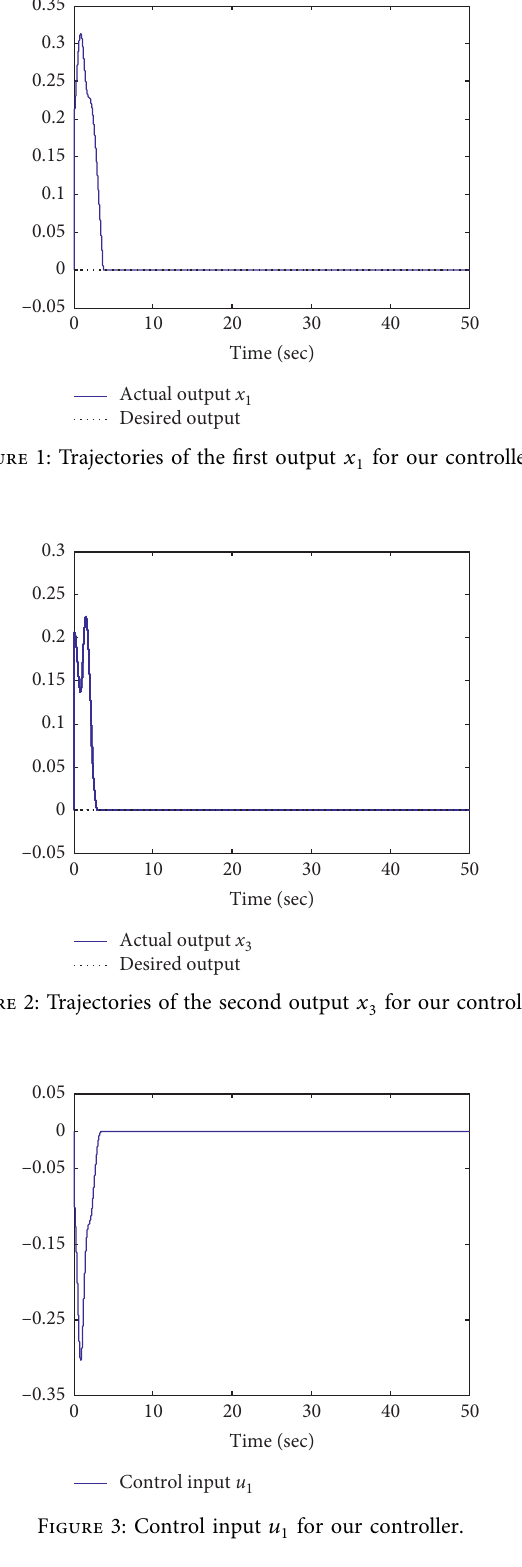
for our controller. 1